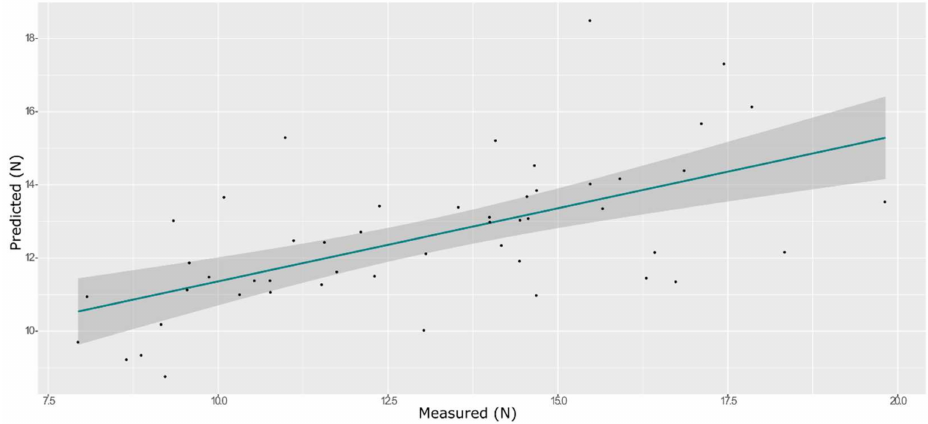
Figure 11. PLS model for BH on the test set, using the selected wavenumbers.